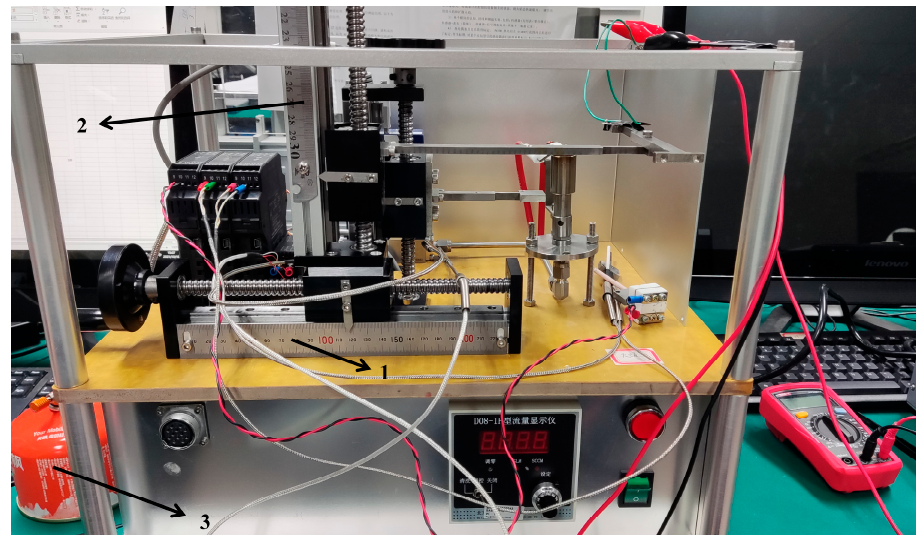
Figure 15. Photo of acetylene flame testing platform (1— X -axis positioning ruler, 2— Y -axis posi- tioning ruler, 3—acetylene gas bottle).